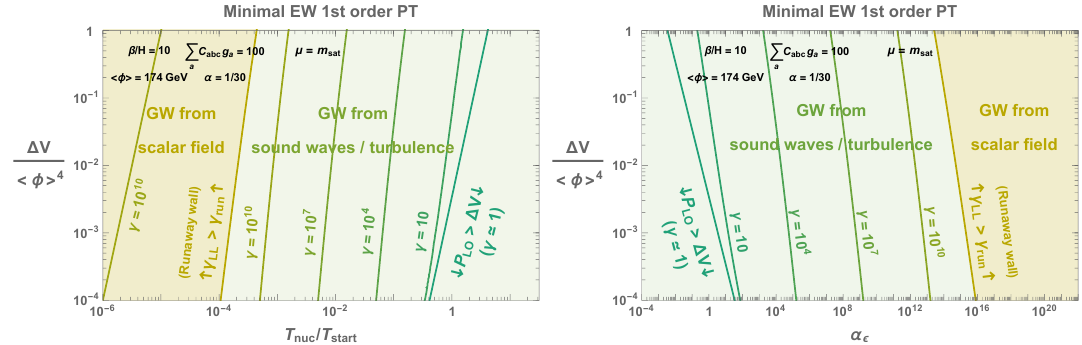
Figure 7 . Bubble wall Lorentz factor γ computed with the results of this paper, see eq. (6.12). In the yellow region, bubble walls collide before they reach their terminal velocity γ . This LL is the so-called run-away regime in which GW are dominantly produced by the scalar field gradient. In contrast, in the green region, bubble wall reach their terminal velocity before collision and the GW signal is dominated by sound-waves and turbulence. In the right-hand panel, α (cid:15) ≡ ∆ V/ρ rad = ( T start /T nuc ) 4 is the latent heat of the phase transition in the Bag model [49], ∆ V is the vacuum energy of the phase transition. For P we use eq. (6.2) and account for the LO contributions from t , W ± , Z and h